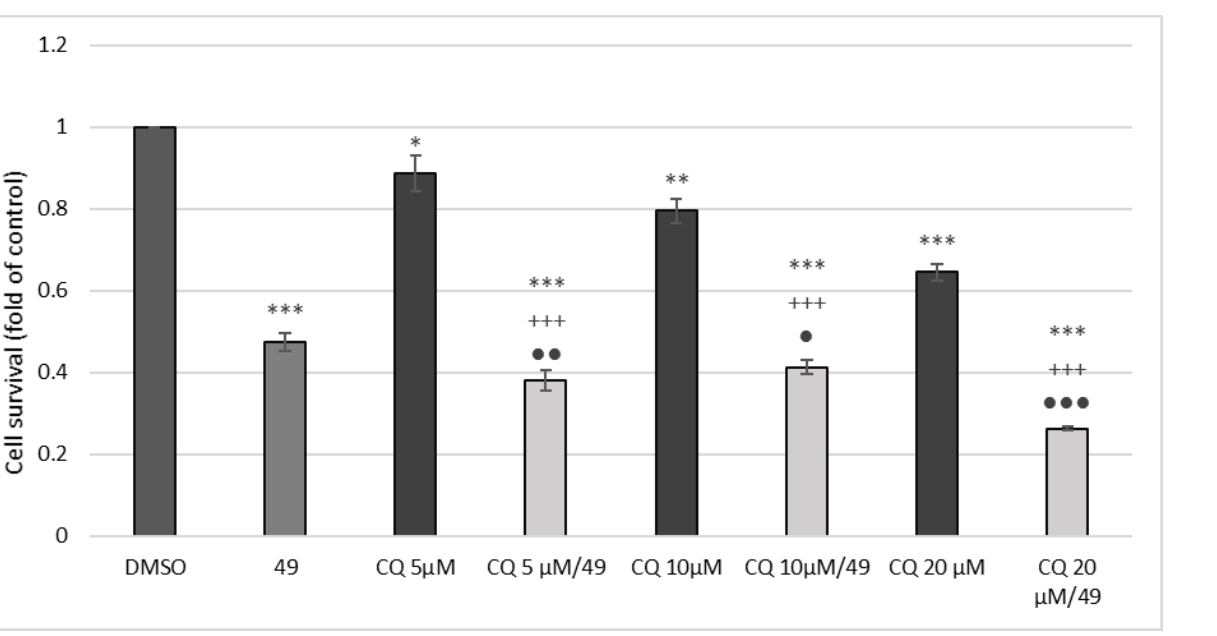
Figure 7. Effect of compound 49 alone or in combination with chloroquine (CQ) on the cell cycle progression of A549 cells after 24, 48 and 72 h incubation. The data show the mean ± SD values of three independent experiments. Statistical significance: * p < 0.05 vs. DMSO, + p < 0.05 vs. CQ, ● p < 0.05 vs. 49.